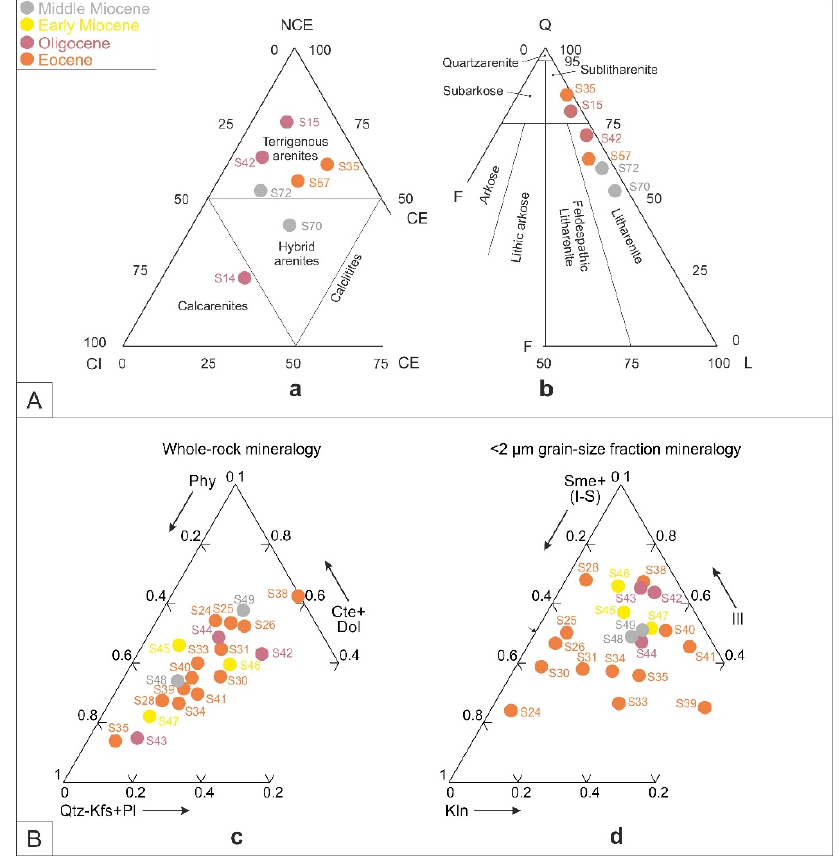
Figure 3. Petrographic and mineralogical composition checked in the arenites clays and marls of the El Habt and Ouezzane Units. ( A ) Arenite composition: ( a ) first-order compositional plot where NCE, Non-carbonate Extrabasinal grains; CE, Carbonate Extrabasinal; and CI, Carbonate Intrabasinal; ( b ) the main composition Q-F-L (Quartz-Feldspar-Lithic frangments including carbonate rocks). ( B ) Mineralogical results of the whole rock ( c ) and for the <2 µm grain-size fraction ( d ).